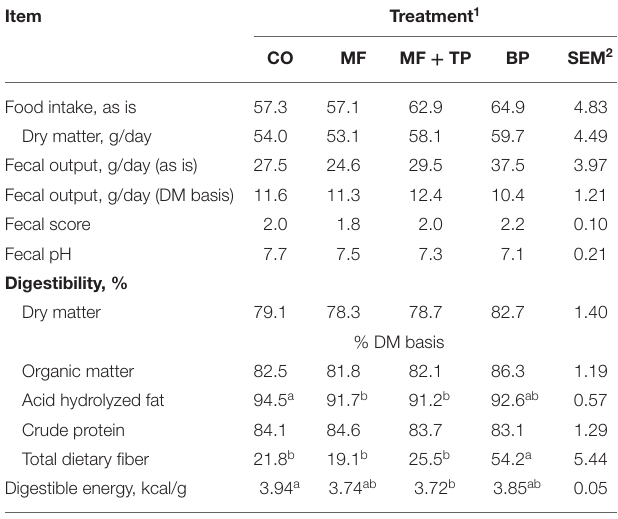
TABLE 3 | Food intake, fecal characteristics, and total tract apparent macronutrient digestibility of adult felines fed dietary treatments containing traditional and novel fiber